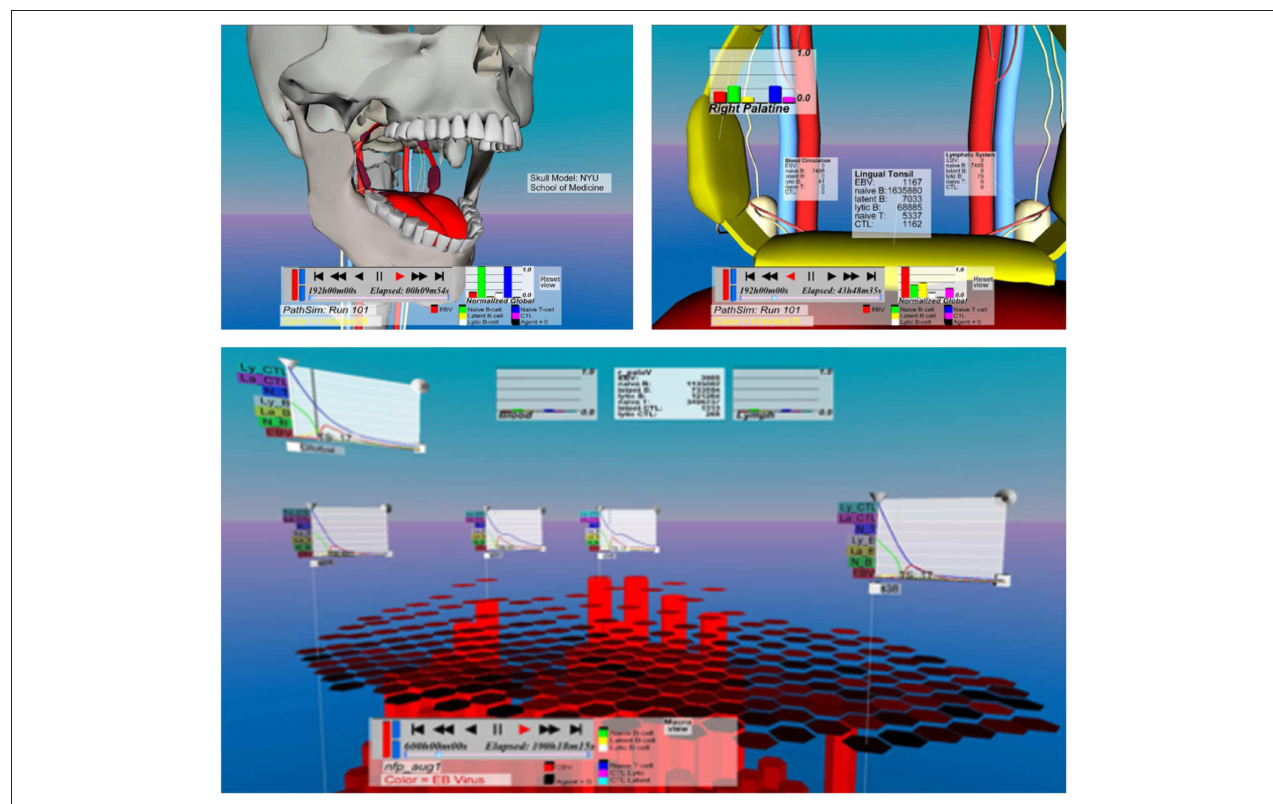
FIGURE 4 | Spatialized information representations across scales in